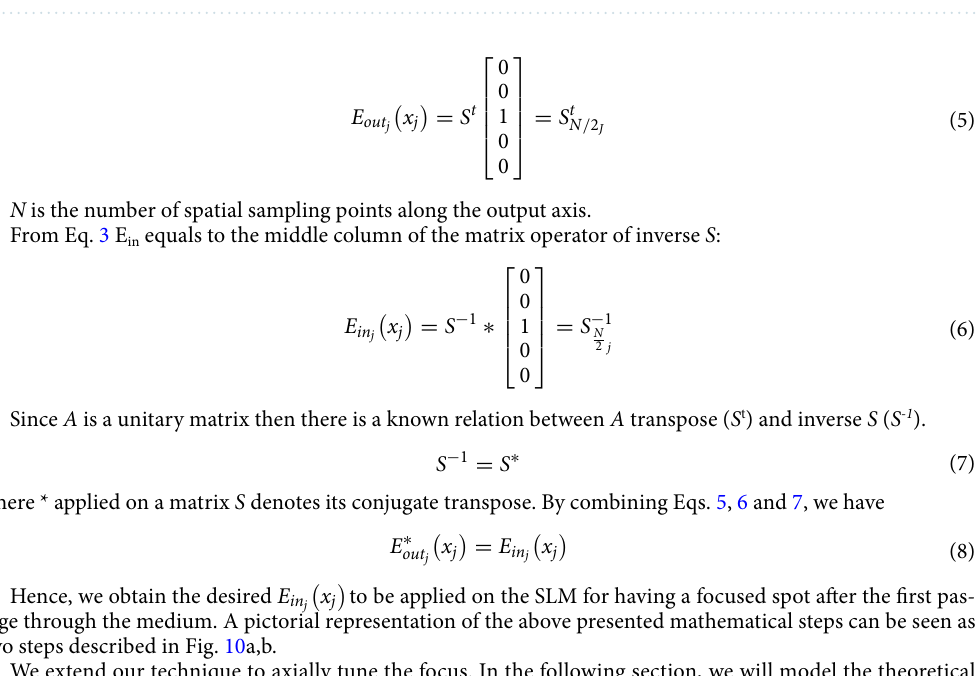
Figure 7. ( a ) Scattered Speckle pattern on CAM2 when the diffuser is illuminated with a plane wave at (z = 150 mm) from the diffuser, ( b )The optimized focus after optimization, ( c ) Intensity profile along an axis for both ( a ) and ( b ) marked in red and blue respectively, ( d ) focal spot scanning along the z axis at z = 100 mm and z = 150